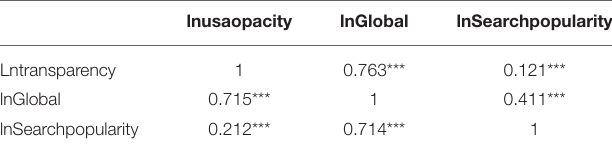
TABLE 3 | Correlation coefficient. lnusaopacity lnGlobal